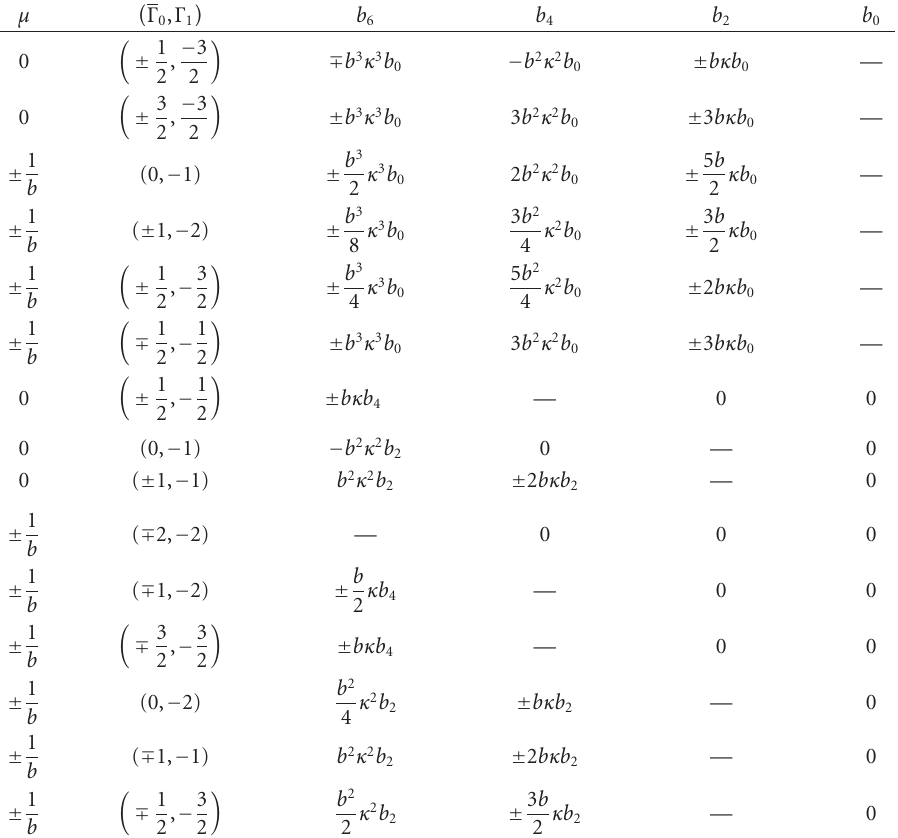
Table 4.1. Solutions of the system